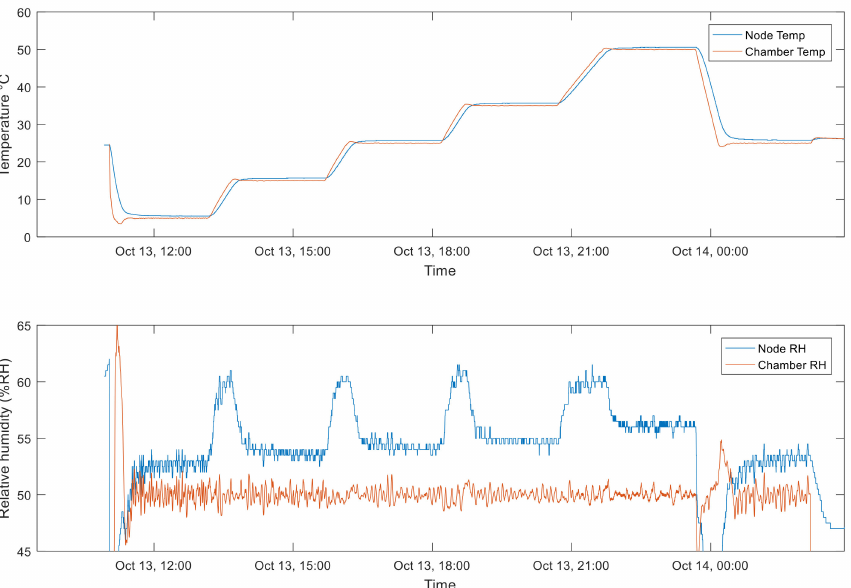
Figure 13. Environmental conditions for the static tests of BME280. Red lines in both subplots show the temperature and RH measured by the built-in sensors of the chamber, whereas blue lines show the measurements of the same quantities performed by the tested sensor